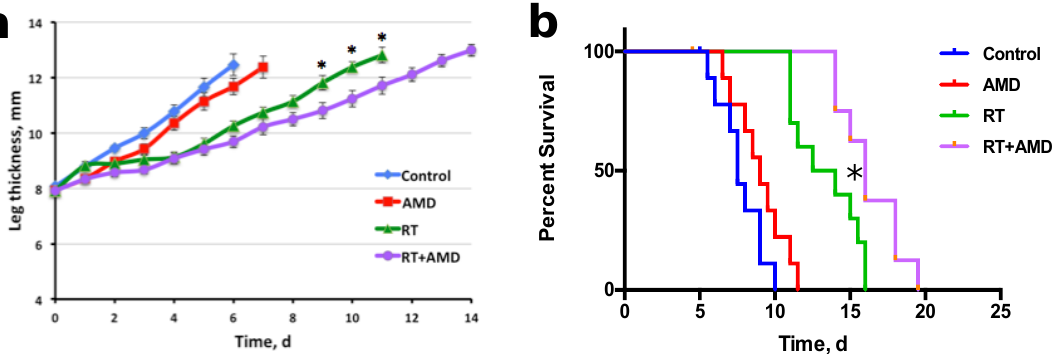
Figure 4. Therapeutic efficacy of post-radiation inhibition of CXCR4 signaling in C57Bl/6 x FVB F1 chimeric mice bearing syngeneic PtenSmad4 -null PCa implanted in the tibia (mPCa model). ( a ) The dynamics of leg thickness (including tumor) following radiotherapy (RT) at a single dose of 12 Gy and/or the initiation of a 2-week AMD3100 (AMD) treatment, compared to control. ( b ) Kaplan–Meier survival distributions in the four treatment groups. * p < 0.05.